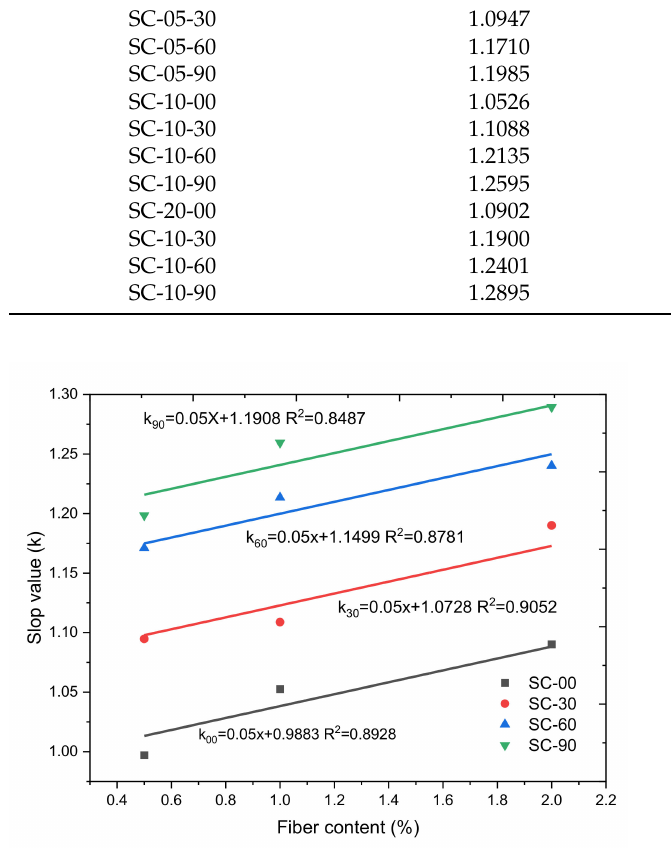
Figure 8. Slope values in terms of fiber content and corrosion